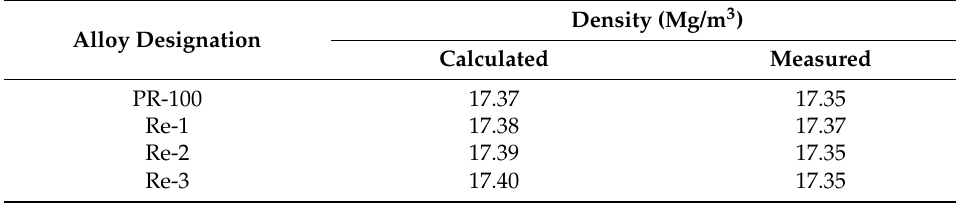
Table 2. Density of